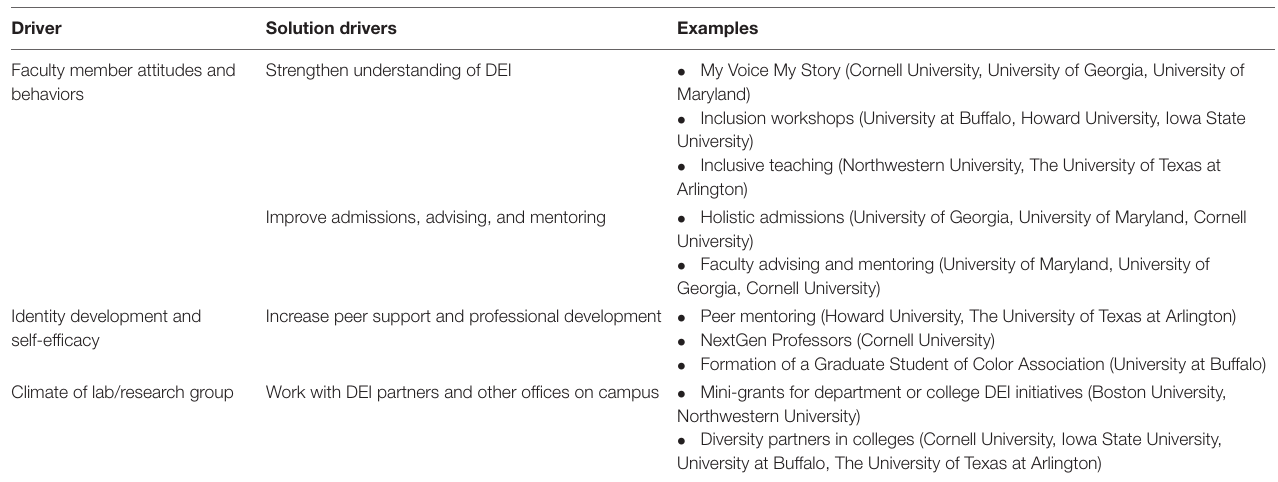
TABLE 2 | Sample of interventions and their alignment with CIRTL AGEP’s driver